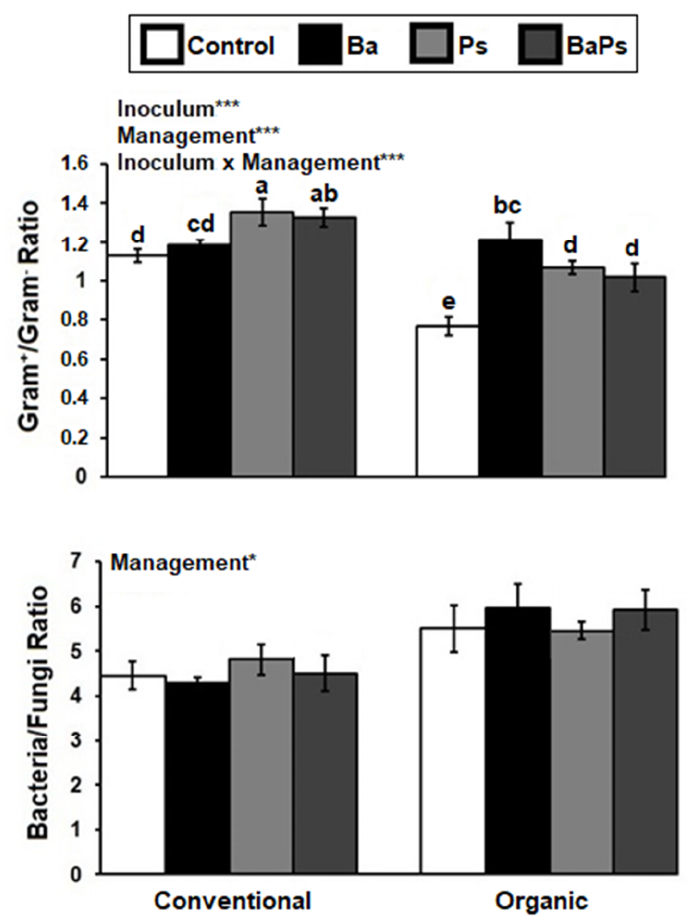
Figure 3. Mean values ( ± SE) of microbial ratios in the conventionally and organically managed systems, at the four treatments. “Inoculum”, “Management”, and “Inoculum × Management” at the top of the graphs, indicate a significant e ff ect of these factors and their interaction, respectively, as revealed by two-way ANOVA (*: p < 0.05, ***: p < 0.001, for all cases n = 4). The di ff erent letters above bars represent statistically significant di ff erences between treatments described by the inoculum type × management system as emerged from Fisher’s test (Fisher post hoc; a: Corresponds to the highest